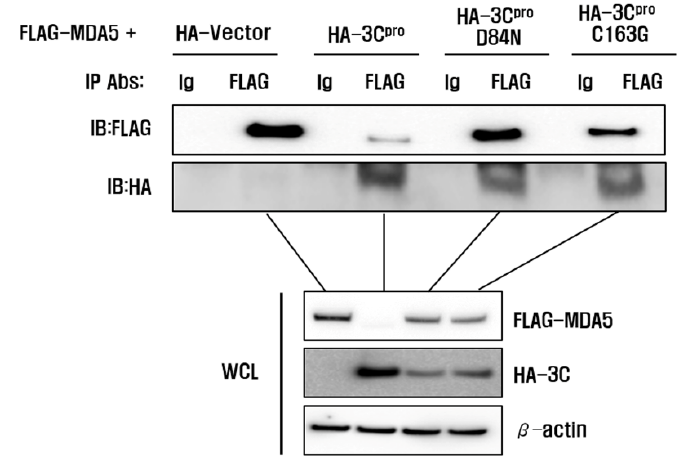
Figure 6. Interaction between 3C pro and MDA5. HEK293T cells grown in 10-cm dishes were co-transfected with FLAG-MDA5 plasmid (8 µL) and the indicated plasmids (8 µL). The cells were lysed at 10 h and immunoprecipitated with mouse anti-FLAG antibody or mouse normal IgG antibody and then subjected to western blotting with anti-FLAG or anti-HA antibodies. Whole cell lysates (WCL) were analyzed by immunoblotting (IB) using anti-FLAG or anti-HA antibodies. All the data were repeated in three independent experiments and data from one of the triplicate experiments are shown.